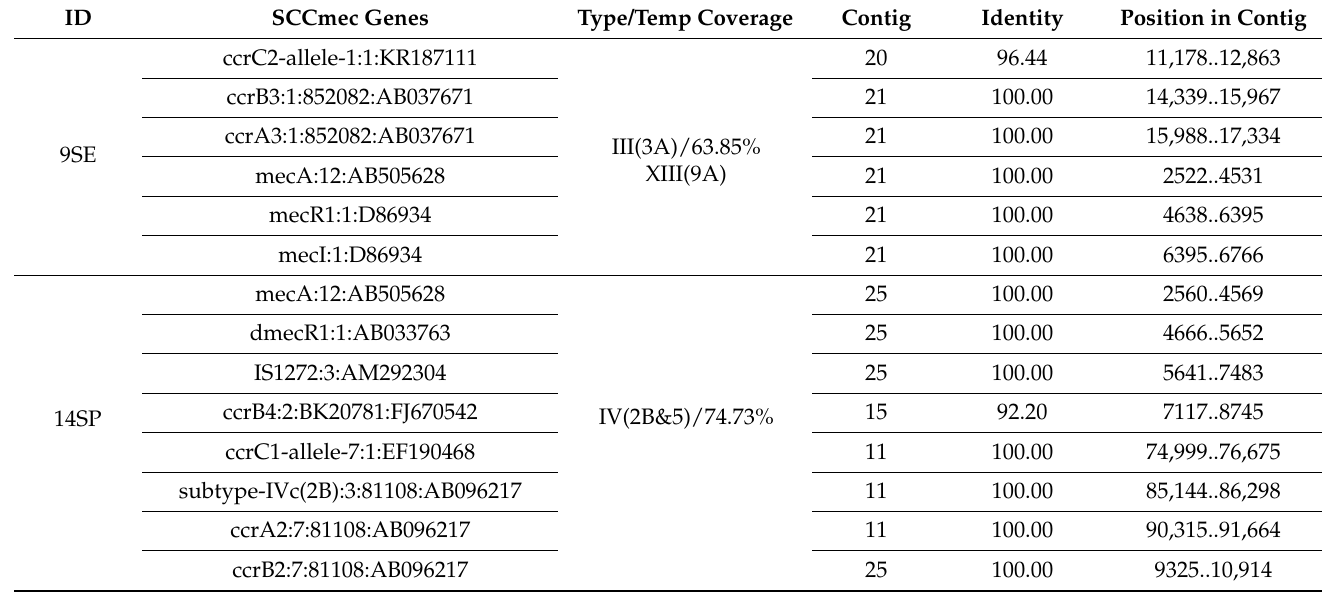
Table 4. SCCmec complex types and their positions in S. epidermidis